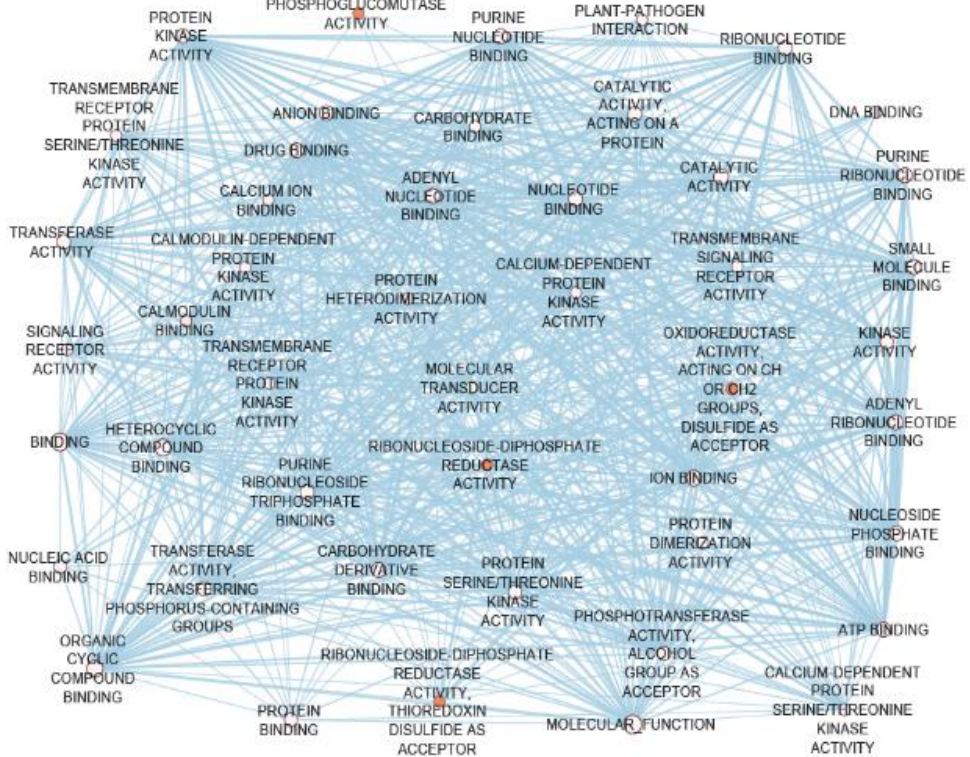
Figure 8. Molecular function network showing interactions (edges) among the gene ontology terms (nodes) enriched within the candidate genes.